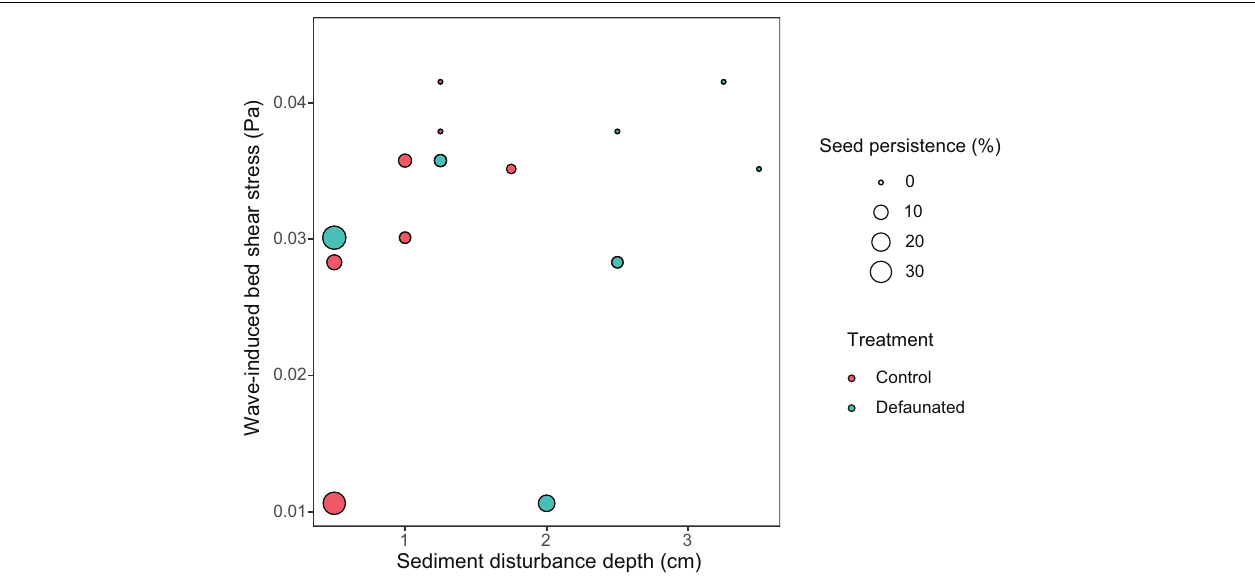
Frontiers in Marine Science |